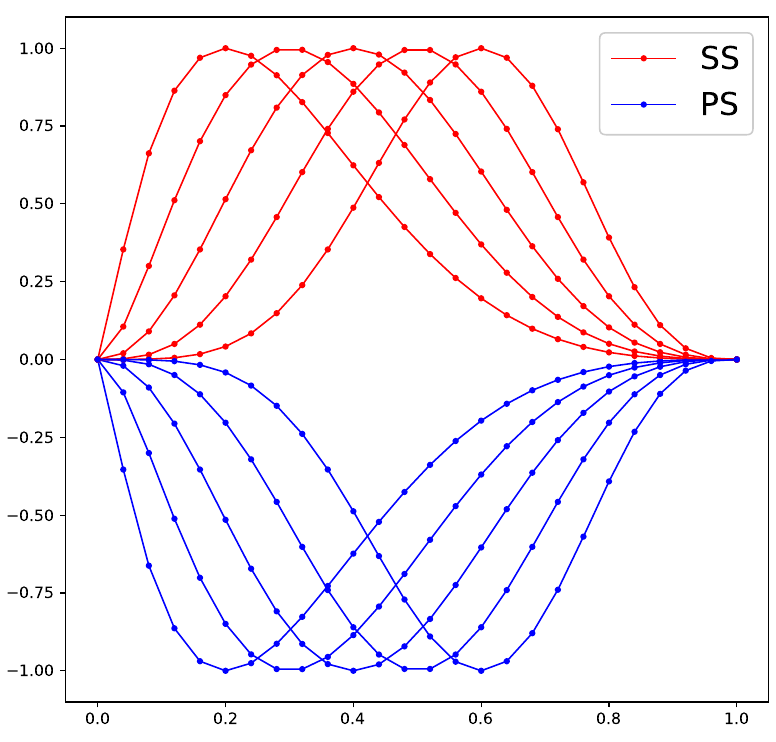
Figure 2. Shape functions of profile perturbation. Table 1. The range of bump function coefficients α i .